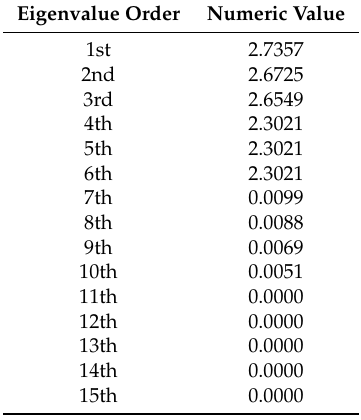
Figure 25. Eigenvector relative to the sixth eigenvalue in the repeated experimental test. Table 6. Stationary eigenvalues ( t = 60 min) of the covariance matrix in the repeated experimental test.